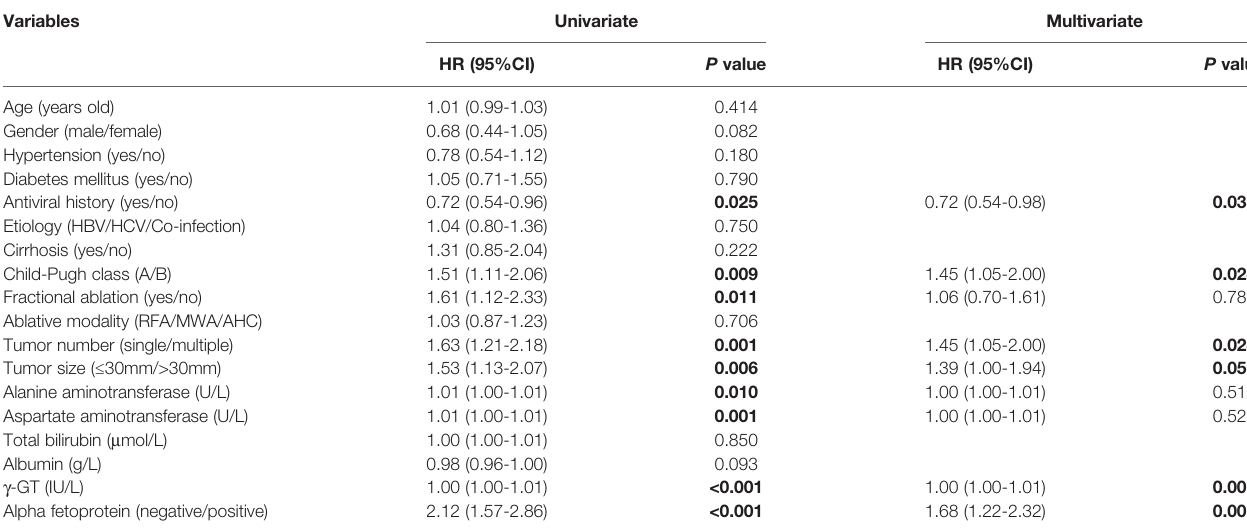
TABLE 4 | AFP at relapse as a prognostic factor associated with RDS. Variables